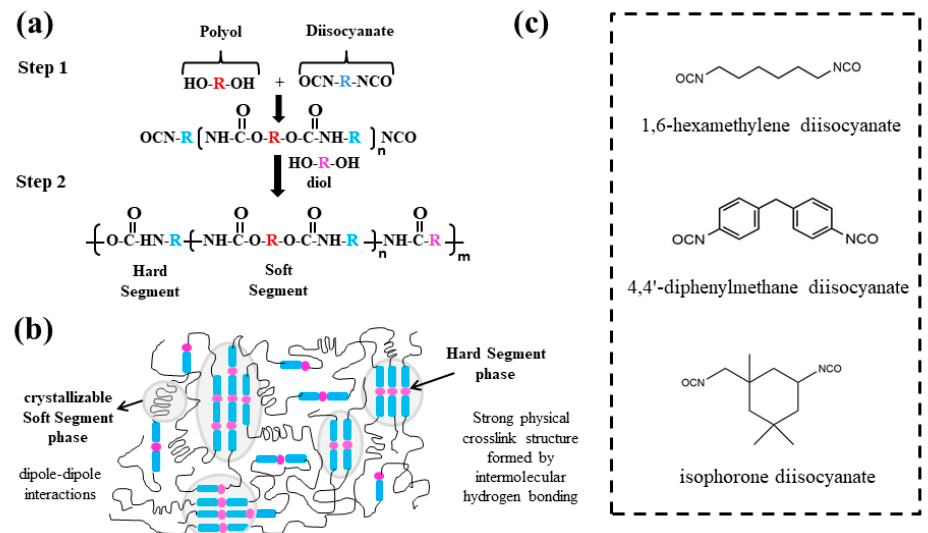
Figure 4. General scheme of the studied TPUs synthesis, where ( a ) synthesis, ( b ) microphase separation structure of hard and soft segments, and ( c ) structure of typical diisocyanates reagents. It is important to note that changes in the mechanical properties of TPUs can occur